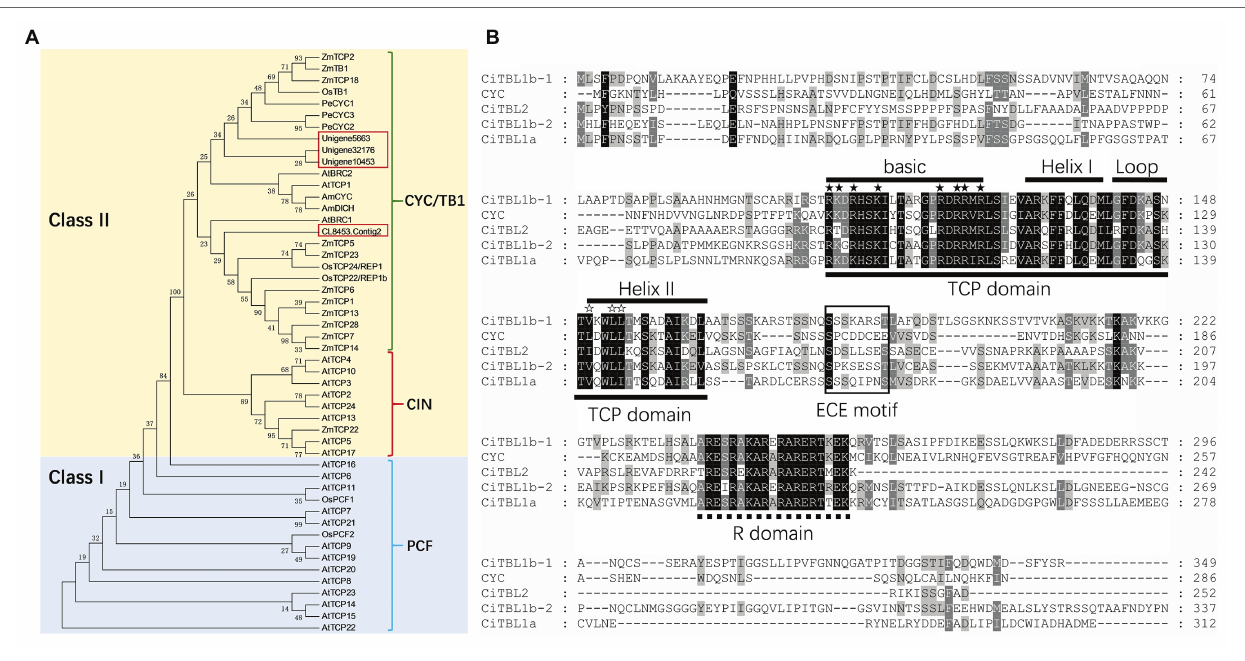
FIGURE 2 | Phylogenetic analysis and protein sequences analysis of CiTBLs . (A) Unrooted phylogram of protein ML analysis with 1,000 bootstraps. All of the AtTCPs and AtBRCs are from Arabidopsis ; AmCYC and AmDICH, Antirrhinum ; OsTCPs, OsPCFs, and OsTB1, rice; ZmTCPs and ZmTB1, maize; PeCYCs, Phalaenopsis equestris . (B) Multiple alignment of putative protein sequences of CiTBL1a, CiTBL1b-1, CiTBL1b-2, and CYC. TCP domain is underlined with the solid line and R domain is underlined with the dotted line.  Indicates the conserved basic residues, and indicates the LXXLL ☆